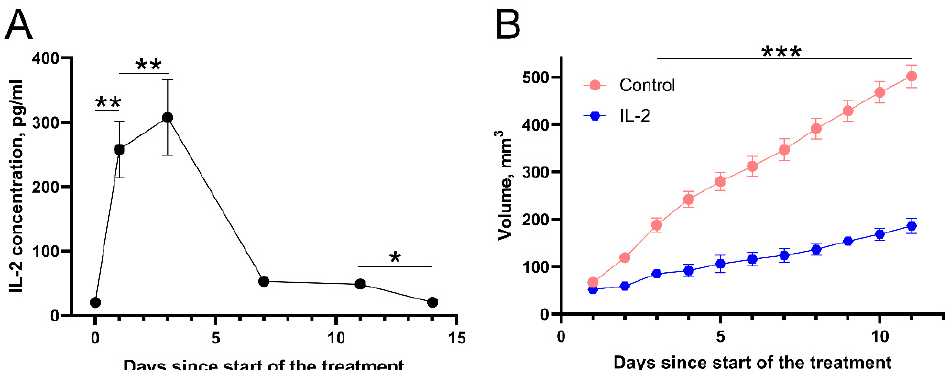
Figure 8. ( A ) IL-2 concentration changes in serum and ( B ) tumor growth changes after IL-coding plasmid electrotransfer into both tibialis anterior muscles during a period of 14 days. Mice bearing two tumors were used for measurement of tumor volume changes. For muscle transfection, IL-2 coding plasmid solution (1 mg/mL) was injected into both tibialis anterior muscles of each mouse and electroporated 10 min later using eight 200 V/cm, 20 ms duration pulses. Statistical significance of the differences between experimental groups was evaluated using t -test. The *, **, and *** symbols represent statistical significance of p < 0.05, 0.01, and p < 0.001, respectively, when compared between corresponding groups ( A ) or to the control (no treatment) ( B ).